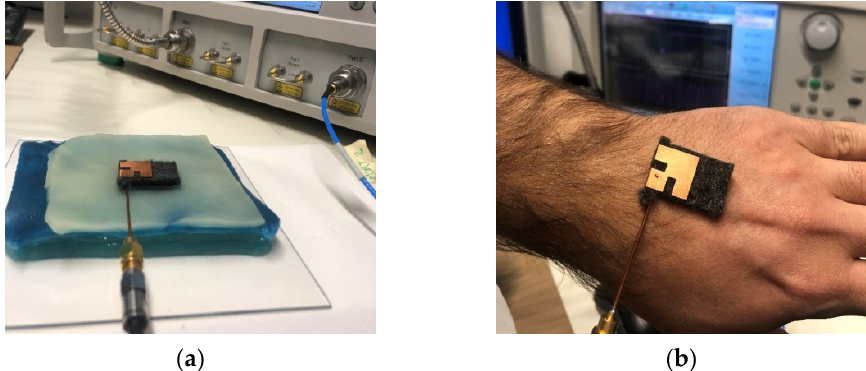
Figure 6. Setup for return loss measurement with ( a ) multi-layer phantom and ( b ) human body.